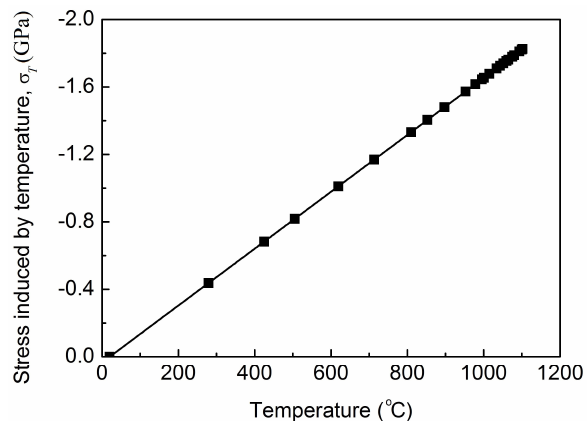
Figure 2. Variation of the thermal stress in the Cr 2 O 3 film with the increase of temperature.